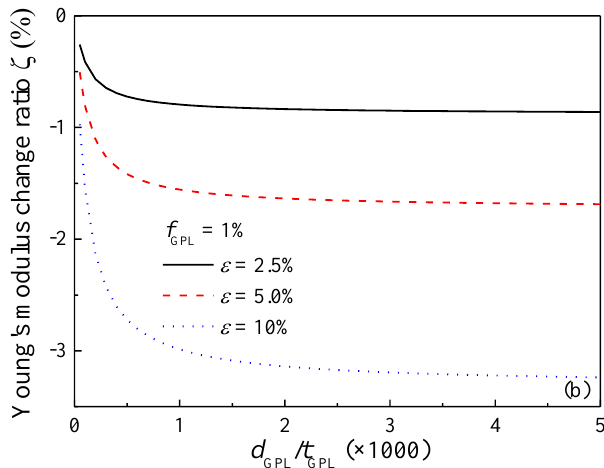
Figure 8. Effect of GPL dimension on Young’s modulus of GPL/Epoxy nanocomposites ( a ) stretching direction; ( b ) transverse direction.